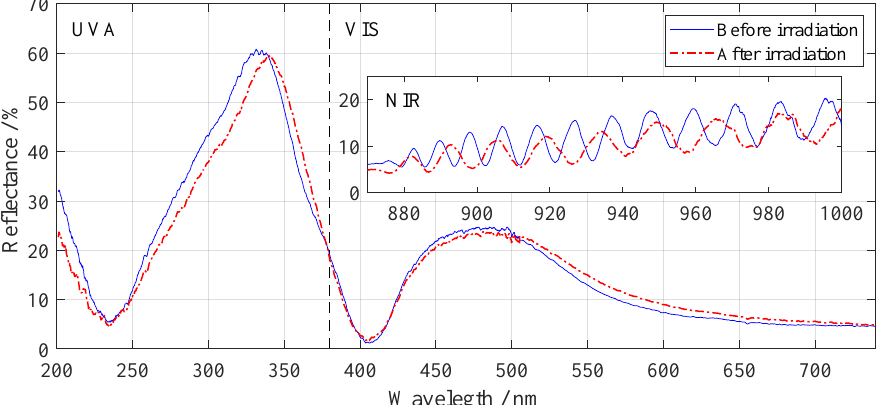
Figure 10. The figure shows the reflectance before and after irradiation, divided into three groups— the ultraviolet spectrum, the visible region, and the near-infrared region. No significant changes are observed in the first two sections mentioned. Noteworthy is the last near-infrared region, where interference fringers give us information about changes in the thickness of the top layers